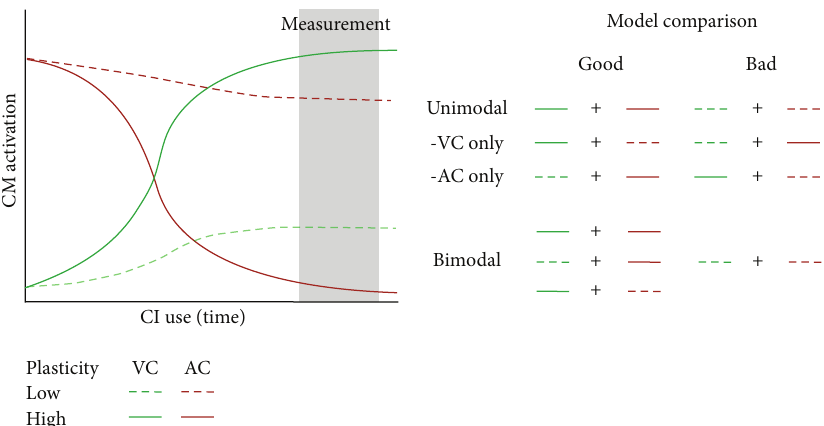
Figure 5: Model of the influence of cross-modal activation of auditory and visual cortex on CI performance. The 𝑦 -axis shows the amount of cross-modal activation and the 𝑥 -axis shows time after CI implantation. The brown lines represent cross-modal activation in auditory cortex (AC), which is assumed to be maximal at time of implantation and reduces with time. The green lines represent cross-modal activation of visual cortex (VC), which develops rapidly after implantation, when auditory input is restored. The dashed lines indicate low plasticity as expressed with small changes after implantation. The solid lines indicate high plasticity as expressed with large changes after implantation. The area between the respective solid and dashed lines represents the potential variation in plasticity. When considering plasticity levels in visual and auditory cortex together (Bimodal), CI users with a solid green line and a dashed brown line or with a solid brown line and a dashed green line would both be considered good performers since in both cases cross-modal activation in visual cortex is higher than in auditory cortex. However, if one considers each sensory modality separately (Unimodal), the prediction would vary depending on the sensory modality considered. Specifically, when considering visual cortex only, one would expect the CI user with a solid green line and a dashed brown line to perform significantly better than the CI user with a solid brown line and a dashed green line. However when considering auditory cortex alone, one would expect the opposite. This ambiguity is resolved with the currently proposed Bimodal